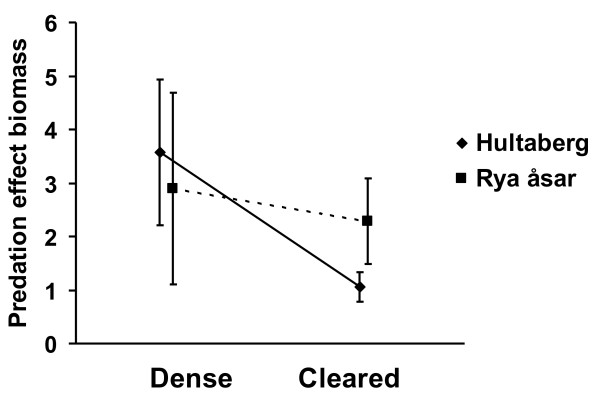
Bird predation effect on arthropod biomass. Bird predation effect (± S.E.) on arthropod biomass in relation to management (dense understory and understory clearance) and site (full line = Hultaberg, dotted line = Rya åsar).